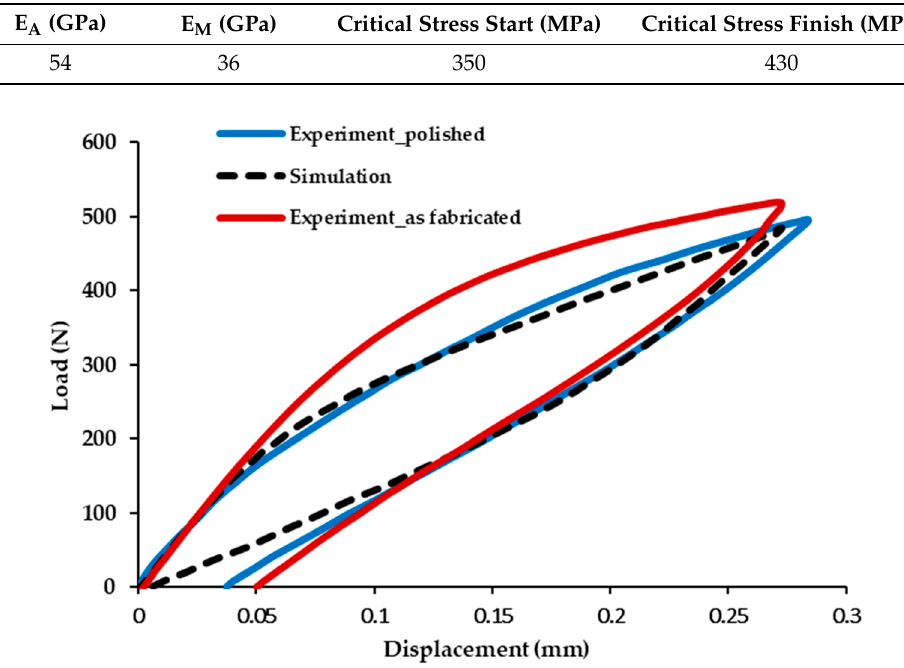
Figure 9. The load–displacement response of as-fabricated porous plate under tensile loading.